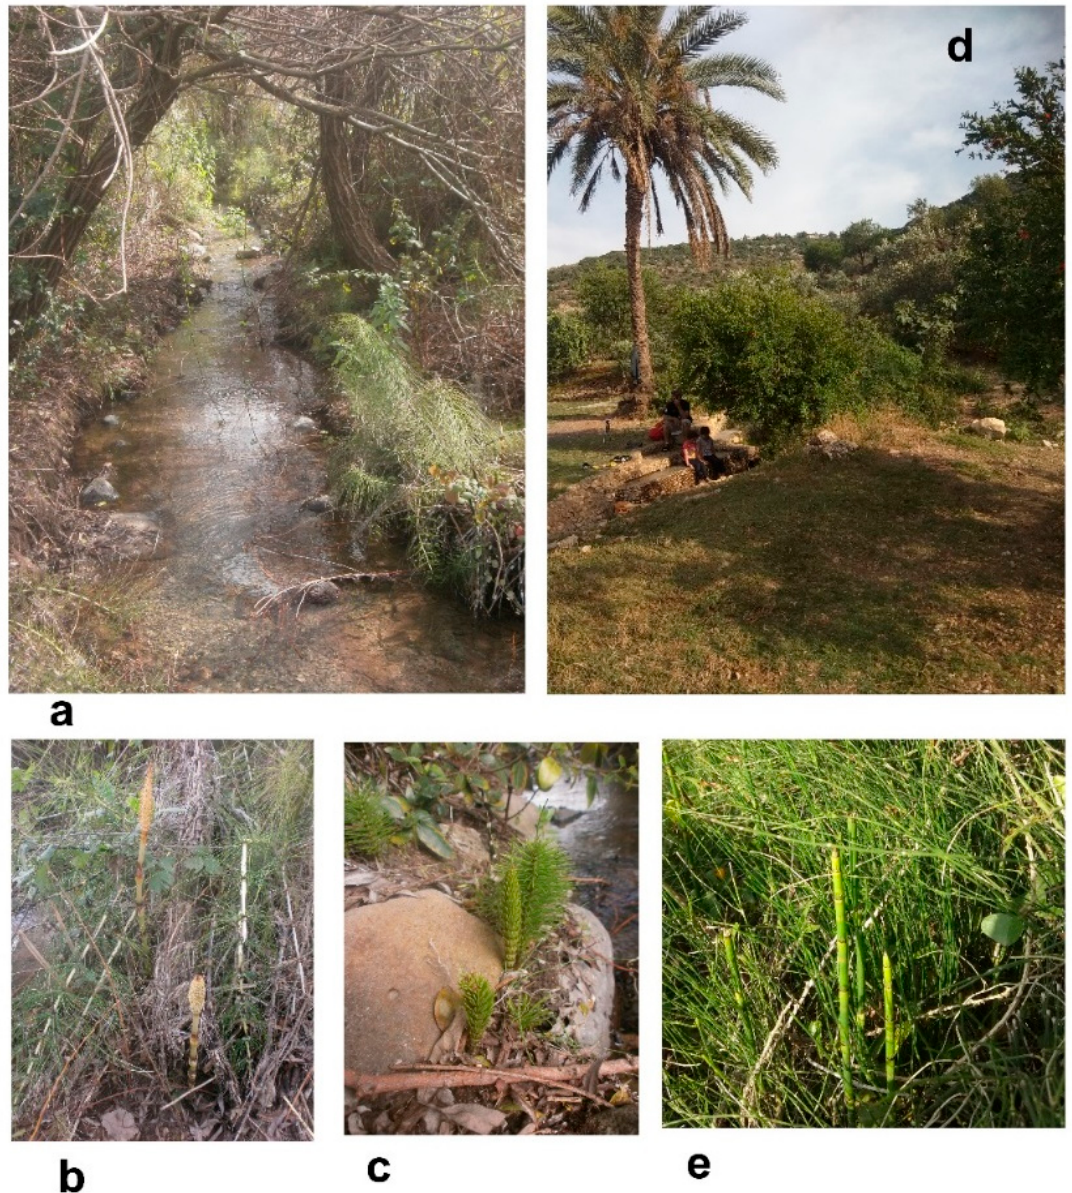
Figure 16. ( a ) Nahal Senir Nature Reserve, Equisetum telmateia on banks of Nahal Senir; ( b , c ) same place, Equisetum telmateia ; ( d ) Nahal Qana, ‘Ein-el-Basa, Equisetum ramosissimum growing in a thicket of Ephedra sp., Rubus sanctus and Smilax aspera ; ( e ) same place, Equisetum ramosissimum .